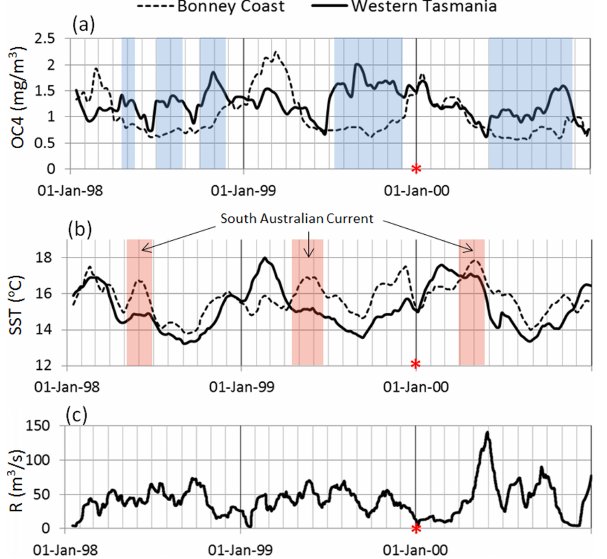
Figure 6. An example of the inflow of warm, nutrient-low South Australian Current that regularly appears along the Bonney coast and on the western Tasmanian shelf between May and July in every year. Data source: Integrated Marine Observing System (IMOS), http://oceancurrent.imos.org.au/Adelaide/2010/2010070104.html.